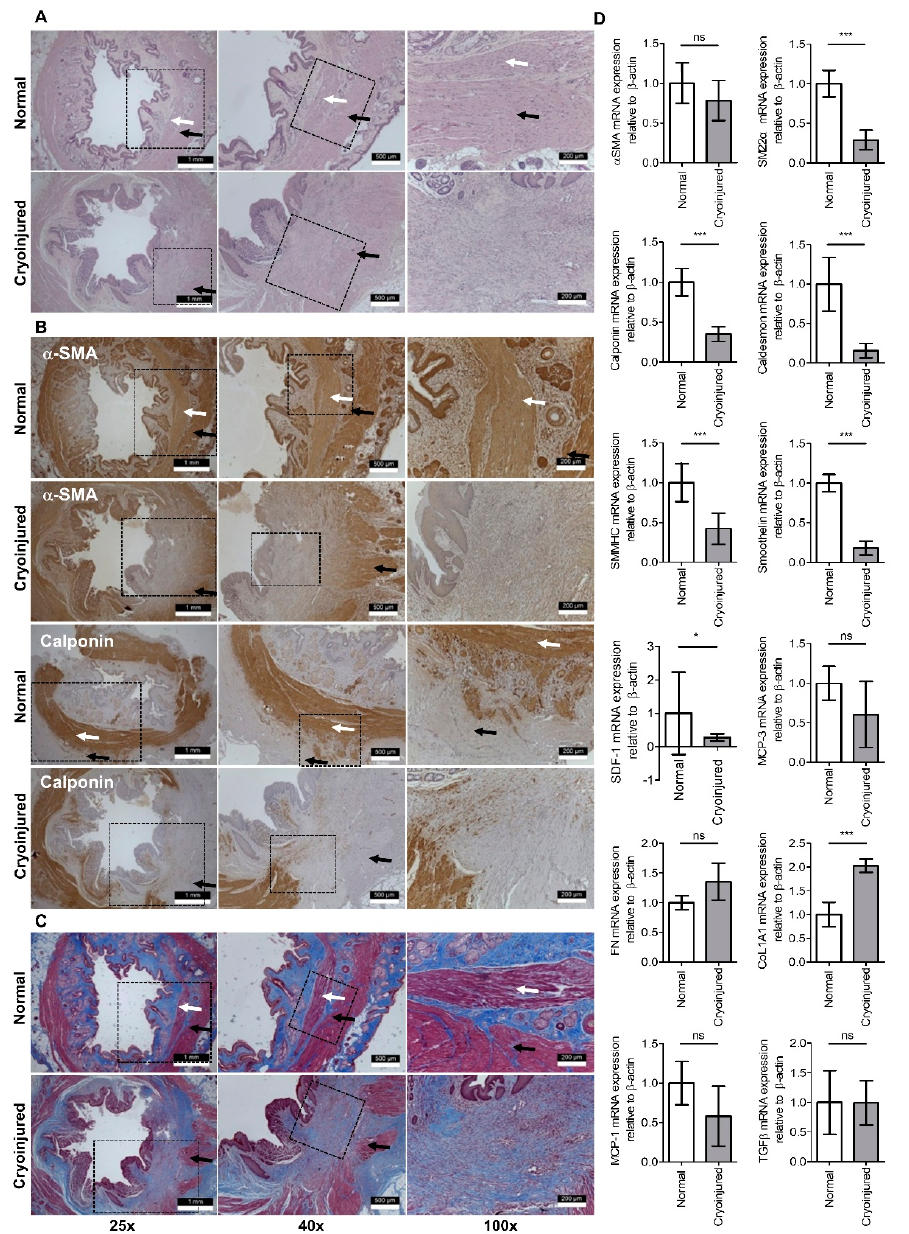
Figure 3. Confirmation of the internal anal sphincter-specific incontinence model. Histopathology showing cryoinjury of smooth muscle in the internal anal sphincter (white arrow) with intact mucosa, submucosa, and circular external sphincter muscle layers (black arrow) compared to the normal anal sphincter on ( A ) H&E staining, ( B ) immunofluorescence staining for α -SMA and calponin, and ( C ) Masson’s trichrome staining. ( D ) RT − PCR analyses of α − SMA , SM22 α , calponin , caldesmon , SMMHC , smoothelin , SDF − 1 , MCP − 3 , FN , CoL1A1 , MCP − 1 , and TFG − β expression in the cryoinjury group and normal group. H&E, hematoxylin and eosin; α -SMA, α -smooth muscle actin; RT-PCR, real-time polymerase chain reaction; SMMHC, smooth muscle myosin heavy chain; SDF-1, stromal cell-derived factor 1; MCP, monocyte chemoattractant protein; FN, fibronectin; TGF- β , transforming growth factor β . Data are expressed as the mean ± SD; * p < 0.05; *** p < 0.001; ns = no statistical